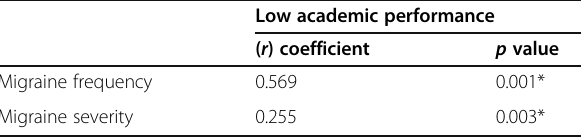
Table 6 Correlation between migraine frequency, migraine severity, and academic performance Low academic performance Migraine frequency 0.569 Migraine severity 0.255